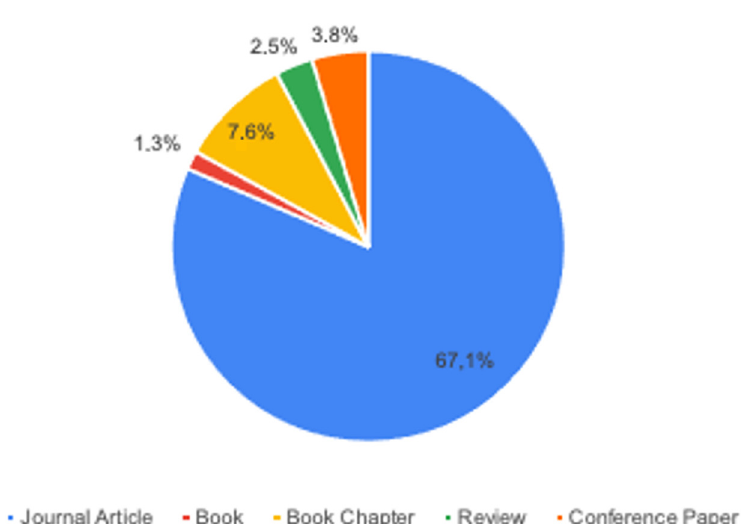
Figure 3. Document Figure 3. Document type. Figure 3. Document type.